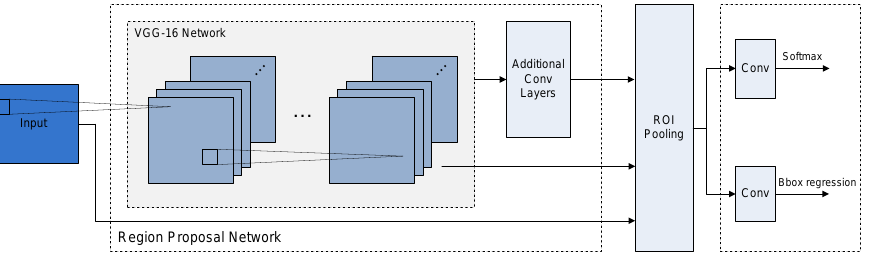
Figure 3. Architecture of the adapted Faster R-CNN model with a VGG-16 backbone. Figure reused from our recent work [8].